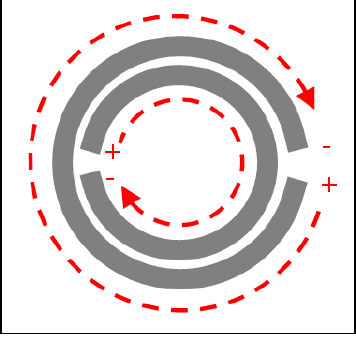
Figure 16. Electric current in SRR unit cell